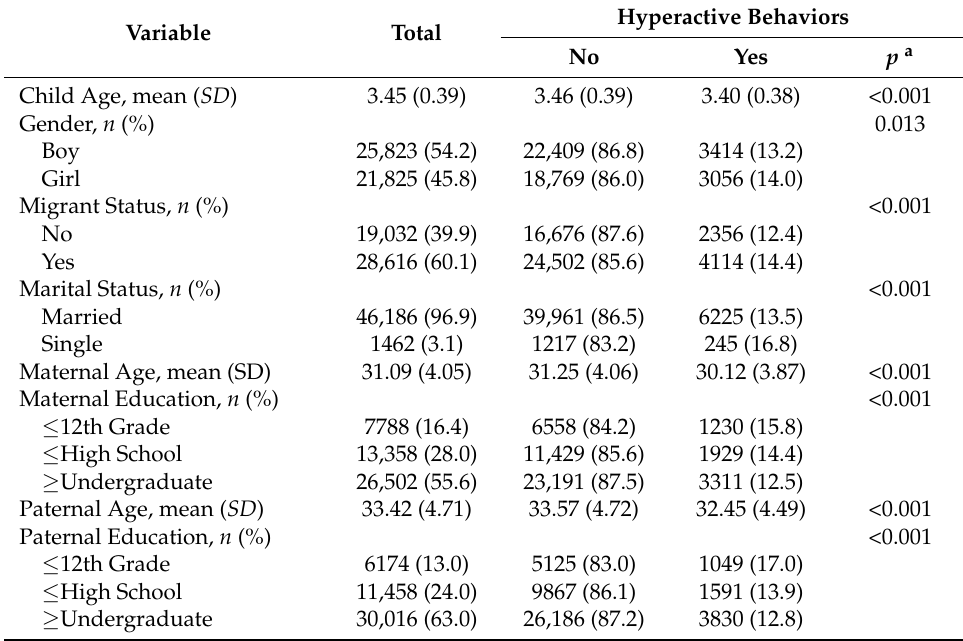
Table 1. Socio-demographic characteristics of